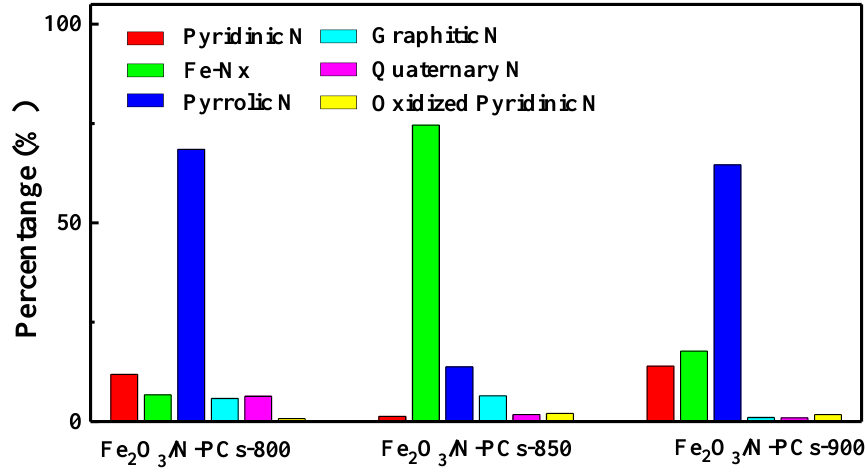
Figure 5 . The percentage of six nitrogen species in Fe 2 O 3 /N-PCs at different temperature. Figure 5. The percentage of six nitrogen species in Fe 2 O 3 /N-PCs at different